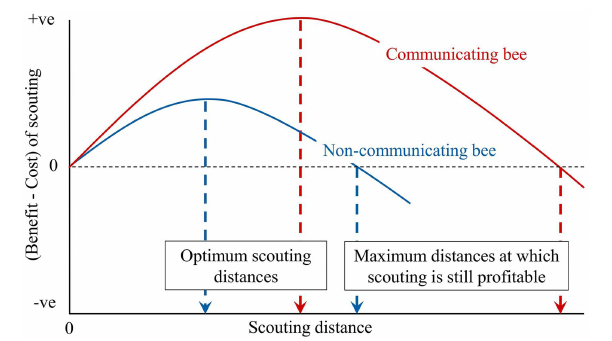
FIGURE 2 | Benefit minus cost for scouting distance for scout bees in a colony. In a communicating bee, such as a honey bee, the benefit is increased as scouts can recruit nestmates to high quality flower patches. More importantly, the distance at which benefit minus cost is maximized is greater in a communicating bee because longer distance scouting results in the discovery of more high quality patches to which recruits can be directed. In a non-communicating species, all bees are scouts as they have to find their own foraging patch. In the honey bee approximately 10% of the foragers are